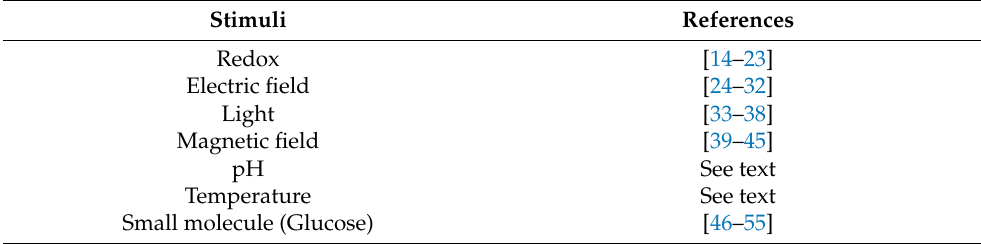
Table 1. Recent literature references for stimuli-responsive chitosan based-nanocomposites.